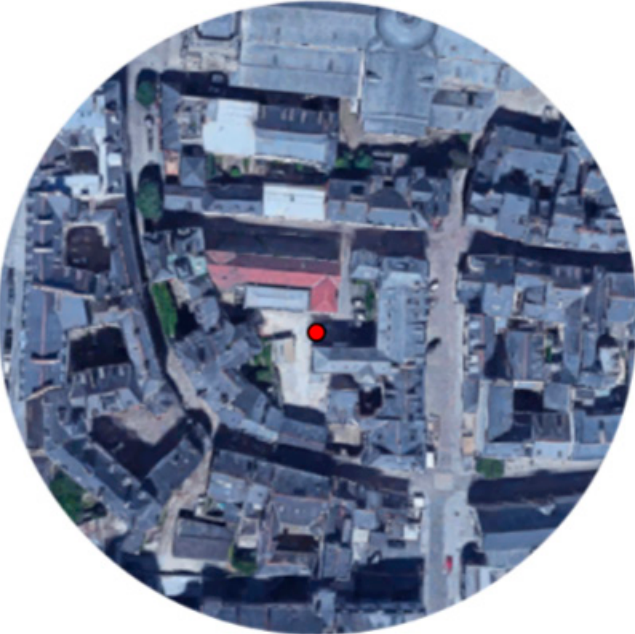
Figure 5. Characteristics of the point representing the urban environment of Rennes (red dot).